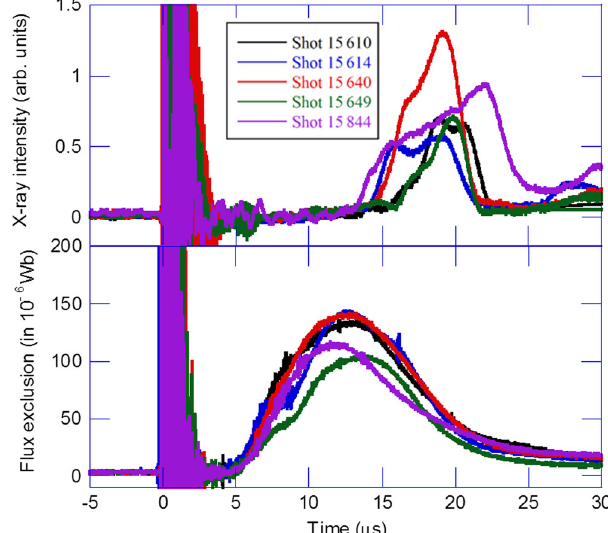
FIG. 11. X-ray emission intensity and flux exclusion from 5 high- β shots with 700-MW input power and 2.7-kG cusp B field (shots no. 15 610, no. 15 614, no. 15 640, no. 15 649, and no. 15